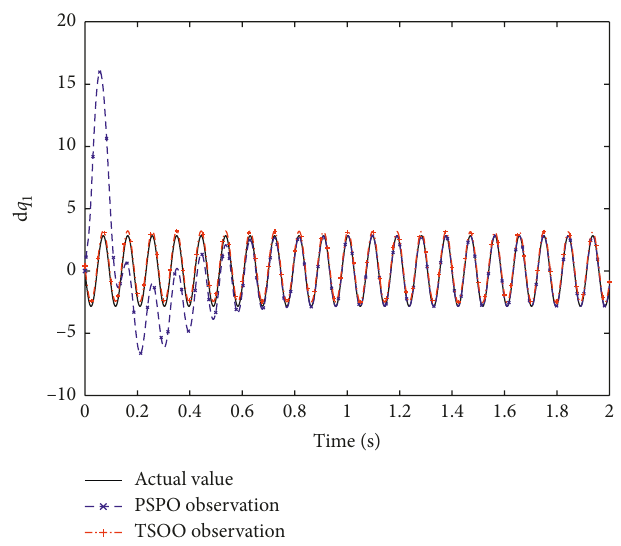
Figure 6: Observation effect comparison for the derivative of the first-order mode